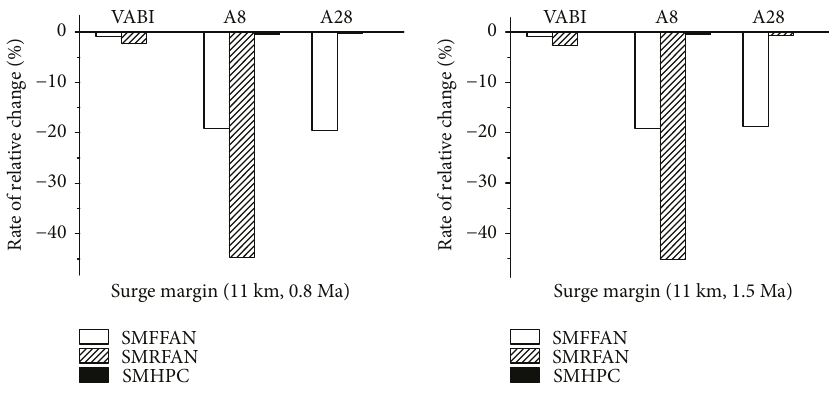
Figure 11: Sensitivity analysis of variable geometries on surge margin (part